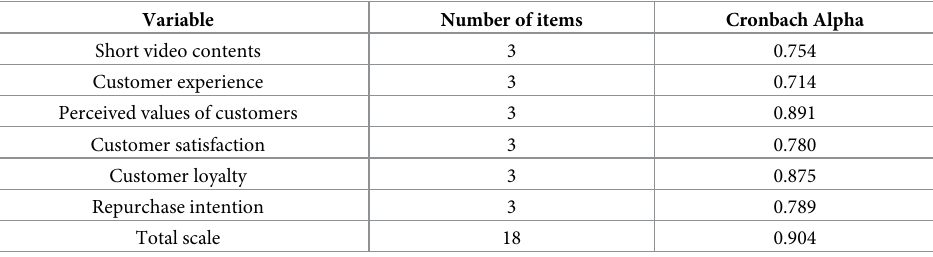
Table 3. Results of reliability